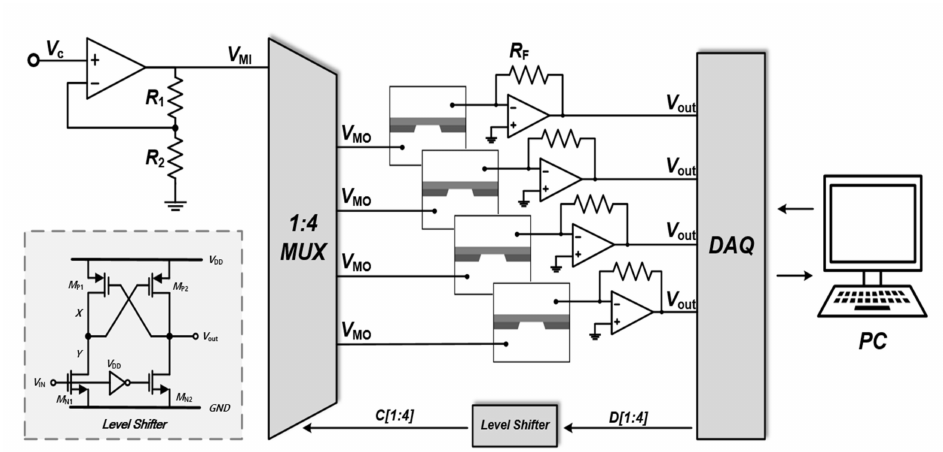
Figure 2. Schematic diagram of the proposed four-channel CDB